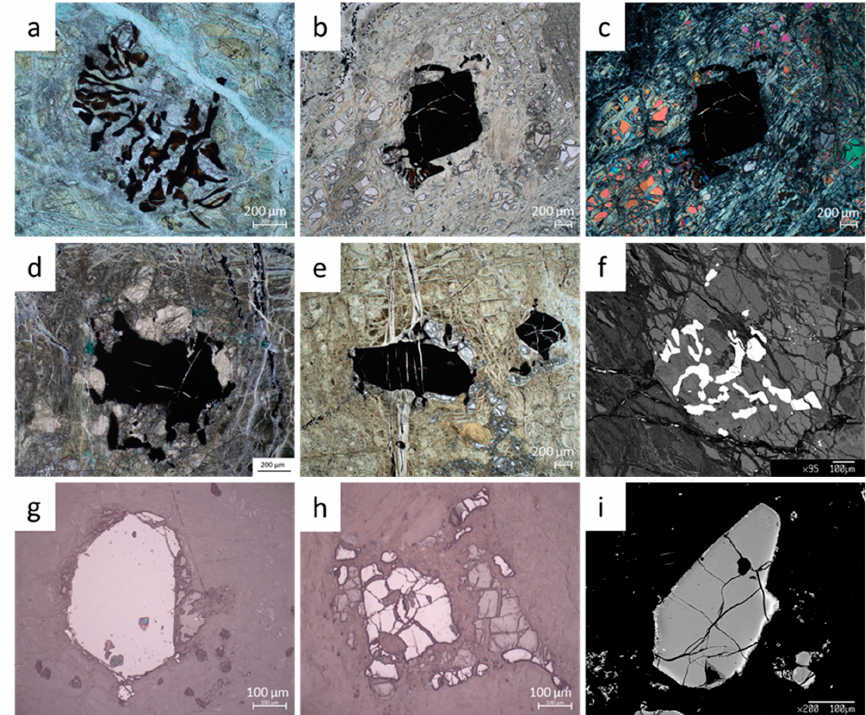
Figure 3. Cr-spinels from Hole BA1B, by optical microscope in Transmitted Light (TL), Reflected Light (RL) and by scanning electron microscope (SEM) in backscattered electrons (BSE). Number of thin